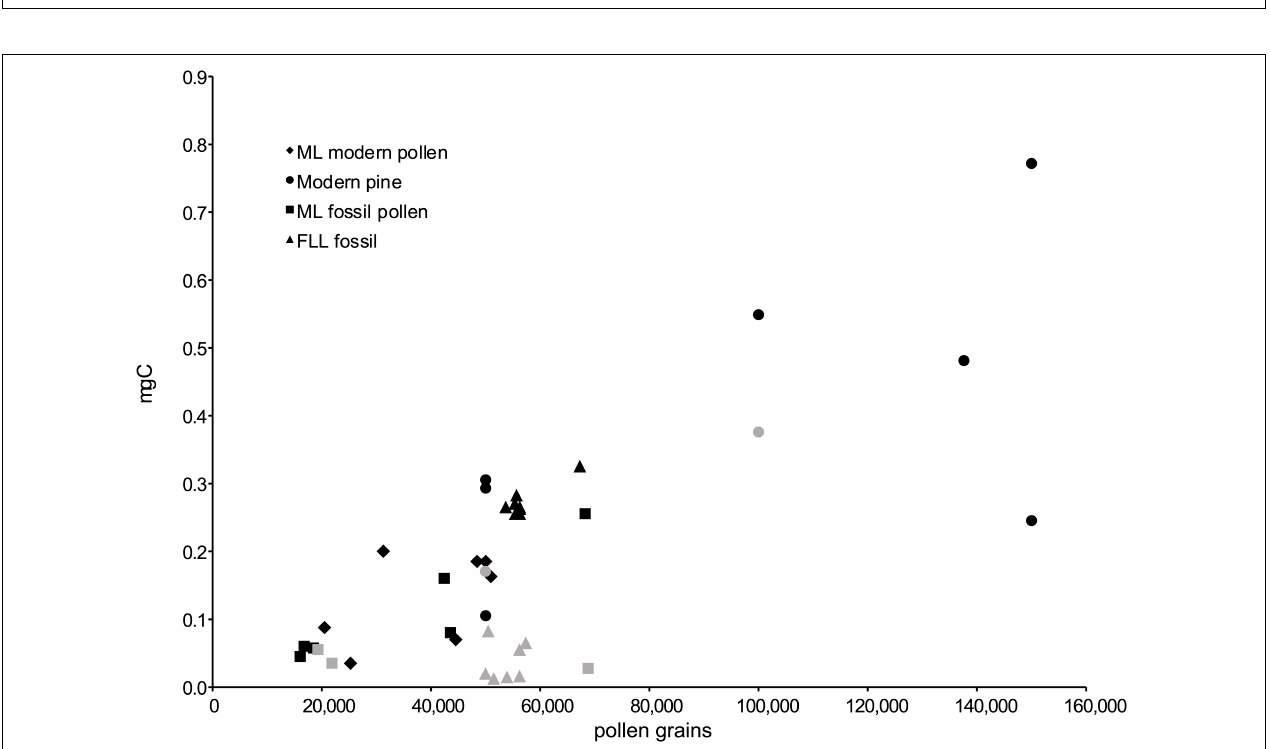
FIGURE 5 | Amount of carbon (mg C) vs. pollen grains in sample, showing only the samples that have been successfully dated. Symbols in gray show the samples that were processed with the lyophilizer, illustrating the significant loss of pollen after sorting and before graphitization. The amount of carbon (mg C) is calculated from the amount of CO 2 after the sorted pollen sample was combusted for graphitization, and the number of pollen grains is the number of “accepted” events counted by the sorter during sorting of the sample.